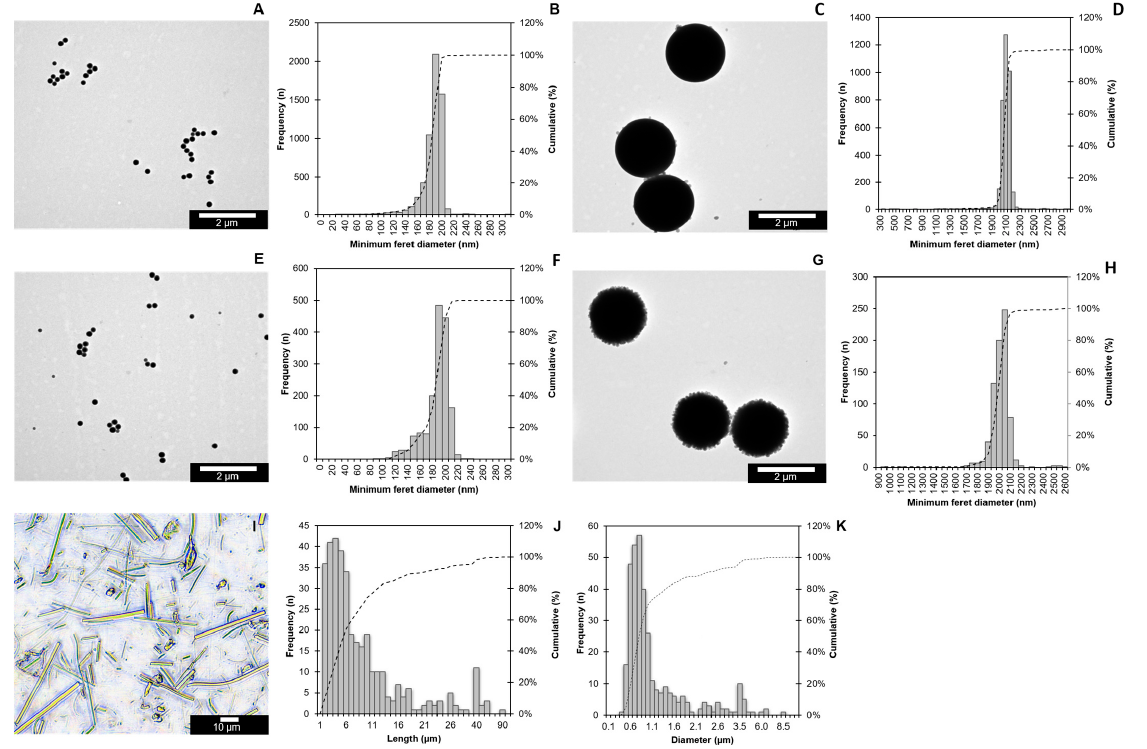
Figure 1. Size distribution of PS-MPs. Representative images of PS200RF ( A ), PS02RF ( C ), PS200NF ( E ), and PS02NF ( G ) were acquired by TEM, while a Nikon light microscope was used to visualise PSMF ( I ). The size distributions of the PS200RF ( n = 5748) ( B ), PS02RF ( n = 3490) ( D ), PS200NF ( n = 1630) ( F ), and PS02NF ( n = 743) ( H ) were assessed by the NanoDefine ParticleSizer plugin software in ImageJ 2.9.0/1.53t (NanoDefine 2016). Length ( J ) and Diameter ( K ) of PSMFs were measured manually using ImageJ ( n = 350). Bars represent the frequency ( n ) (left y -axis), and dotted lines represent the cumulative frequency percentage (%) (right y -axis). Table 4. Physical characteristics of PS-MPs based on TEM and DLS/SLS in stock suspension and cell culture medium.